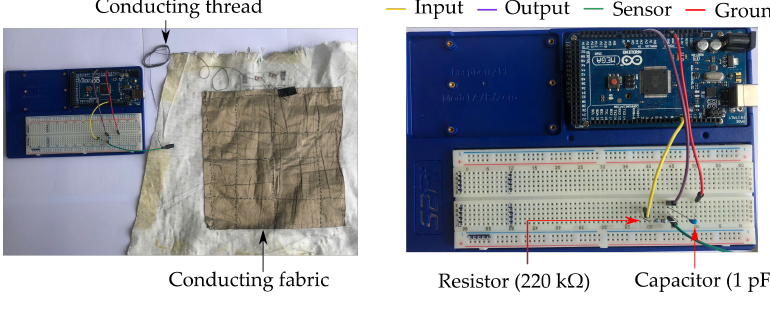
Figure 6. Hardware connections.